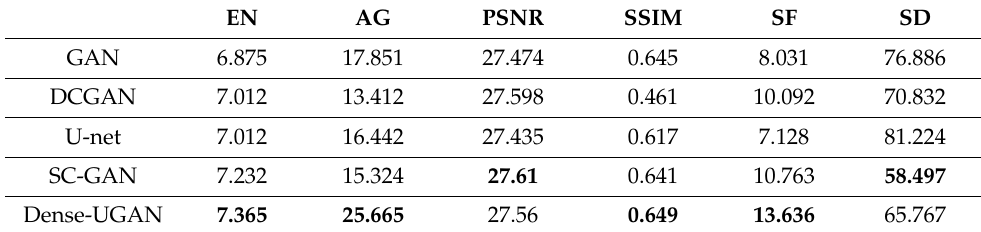
Table 1. Various network test results using the original loss